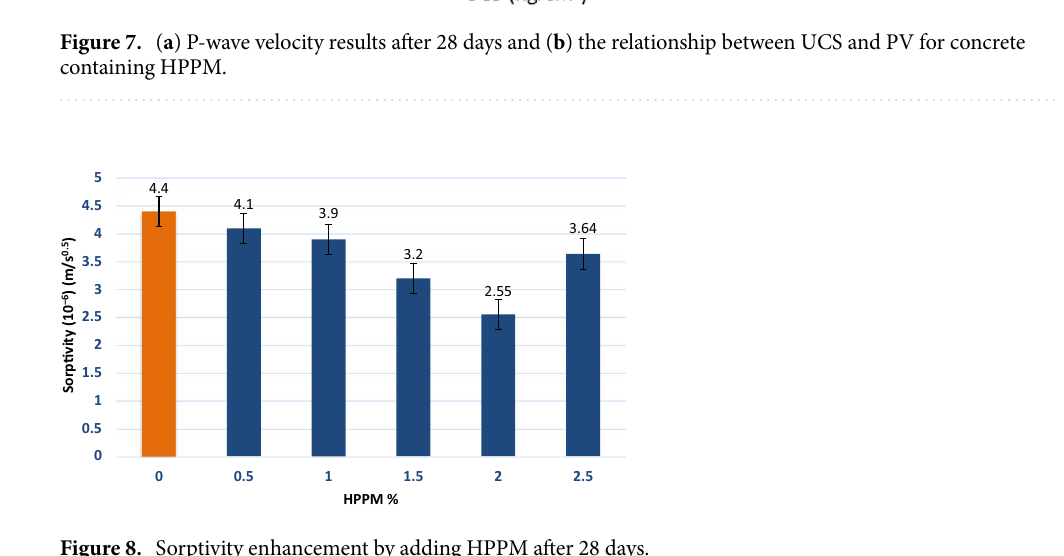
Figure 8. Sorptivity enhancement by adding HPPM after 28